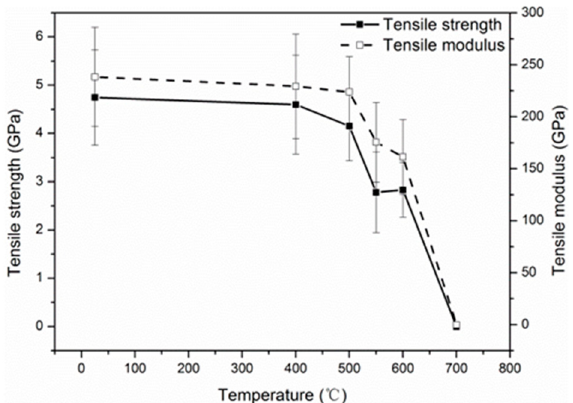
Figure 3. Effects of elevated temperatures on the mechanical properties of single carbon fibers. Note: the exposure time was 30 min at each temperature.